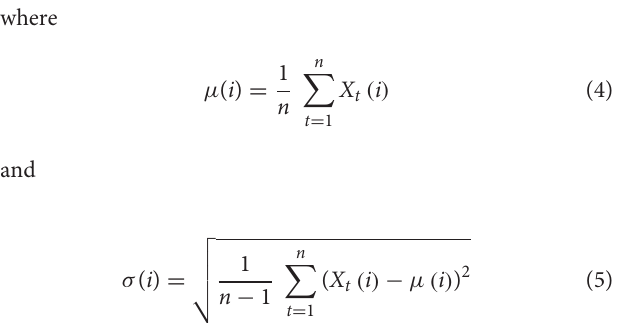
Frontiers in Water |